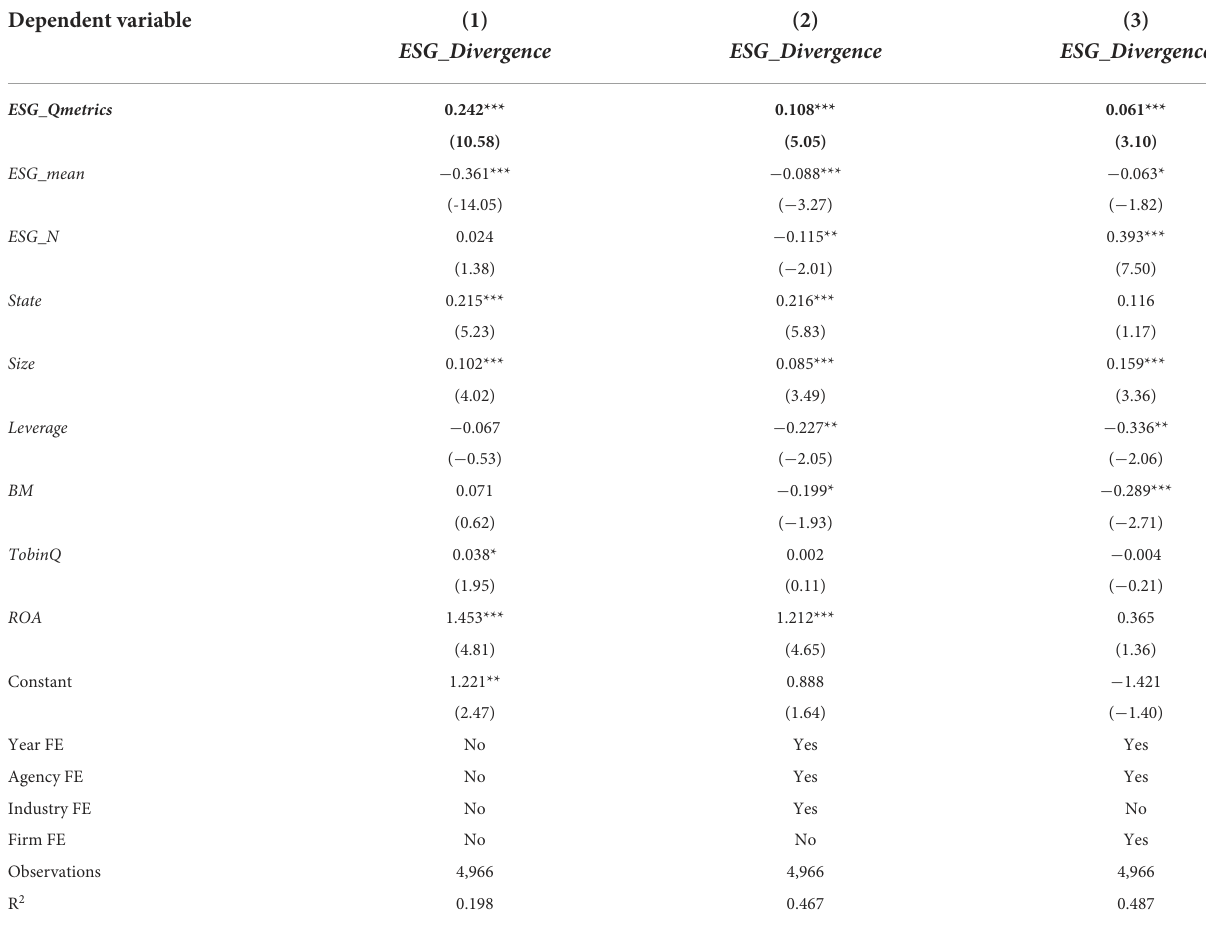
TABLE 3 Effect of ESG quantitative disclosure on ESG rating